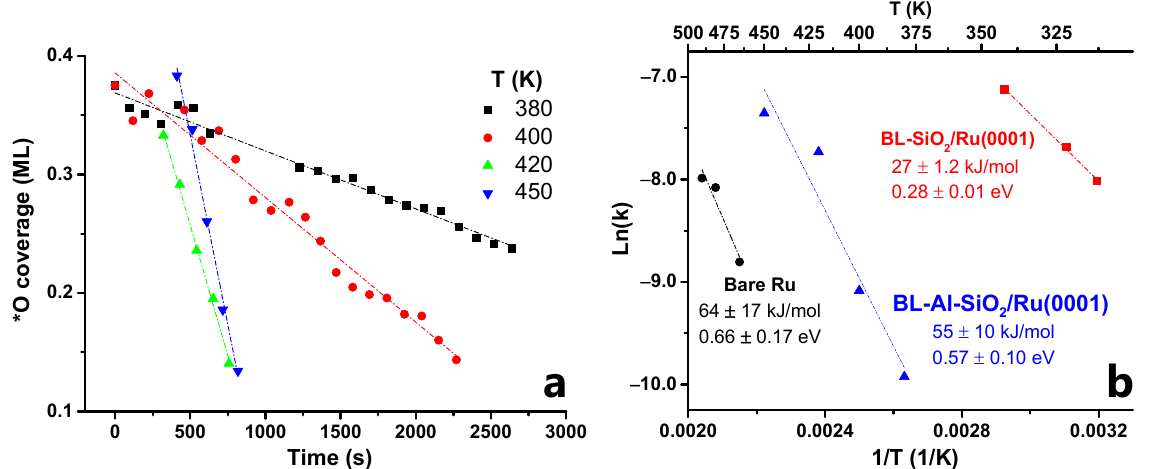
Figure 5. ( a ) Plot of oxygen coverage vs. time at 380, 400, 420, and 450 K; ( b ) Arrhenius plots for WFR at the BL-aluminosilicate/Ru(0001) interface (this work, blue triangles), compared to similar prior work on bare Ru(0001) (black circles) and BL-silica/Ru(0001) (red squares).